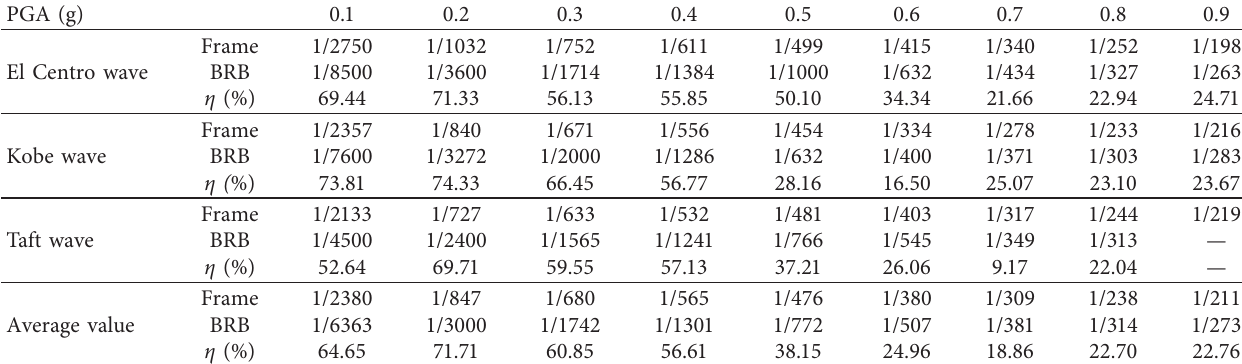
Table 5: Interstory drift ratios of the